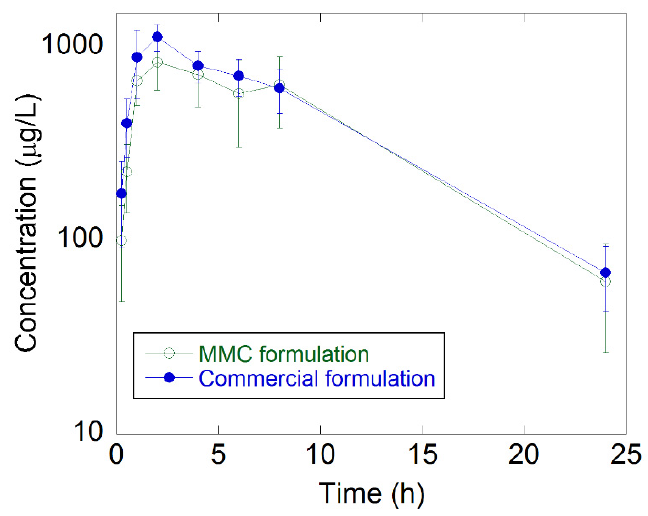
Figure 4. Plasma concentration–time curves for the MMC and the commercially available formulation. The error bars are based on n = 6. Table 1. Summary of calculated pharmacokinetic parameters. The values are an average of n = 6 animals per group. Abbreviations: C max , maximum concentration; T max , time to reach maximum con- centration; T 1/2 , terminal half-time; AUC, area under the curve.